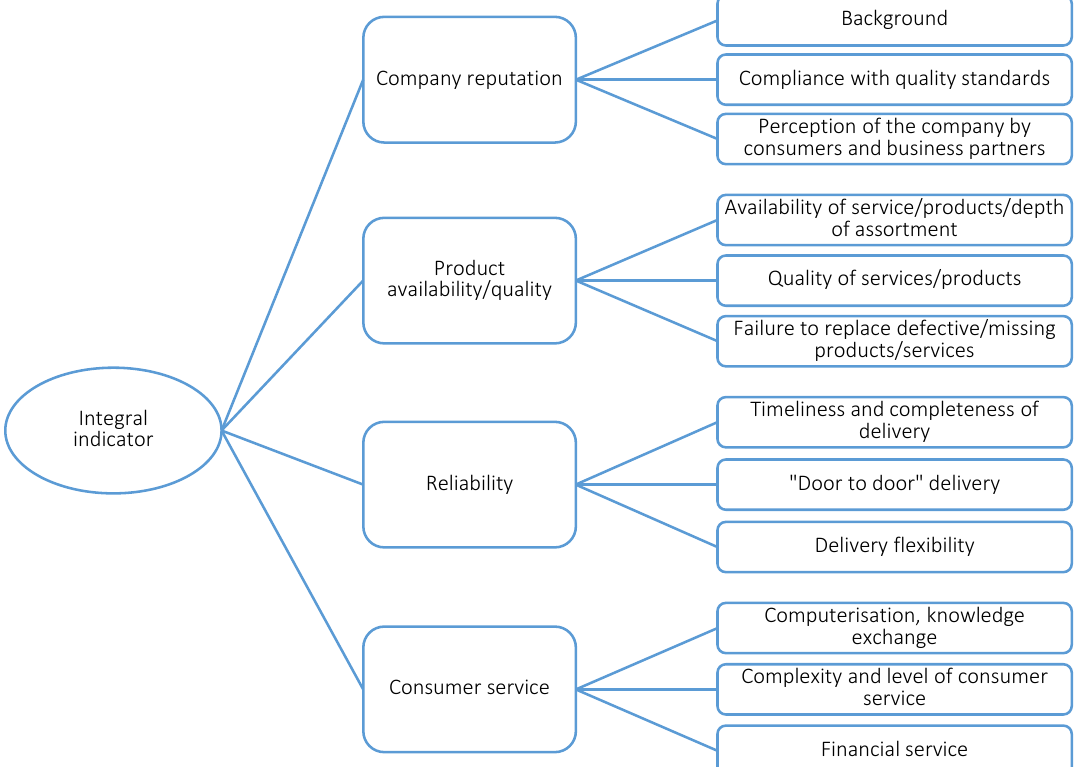
Figure 2. Model for evaluating the logistics service quality of logistics operators/providers